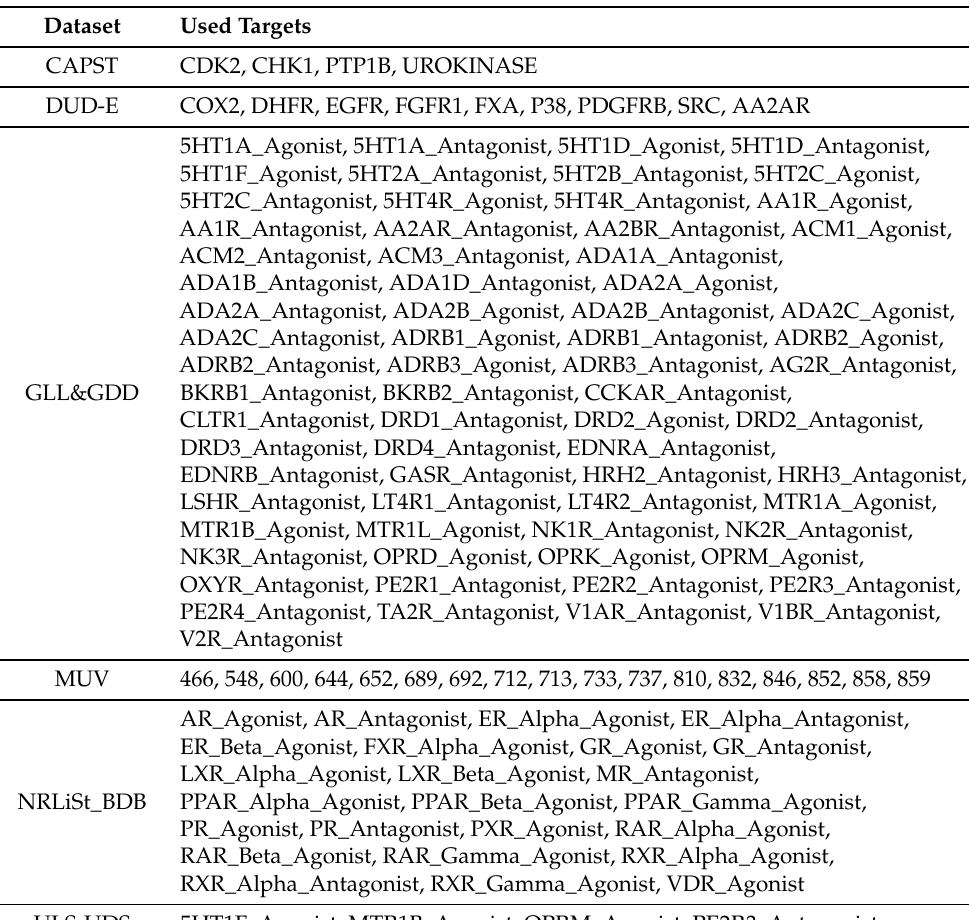
Table 1. Datasets used for the experiments. Each dataset on the left contains the targets on the right.